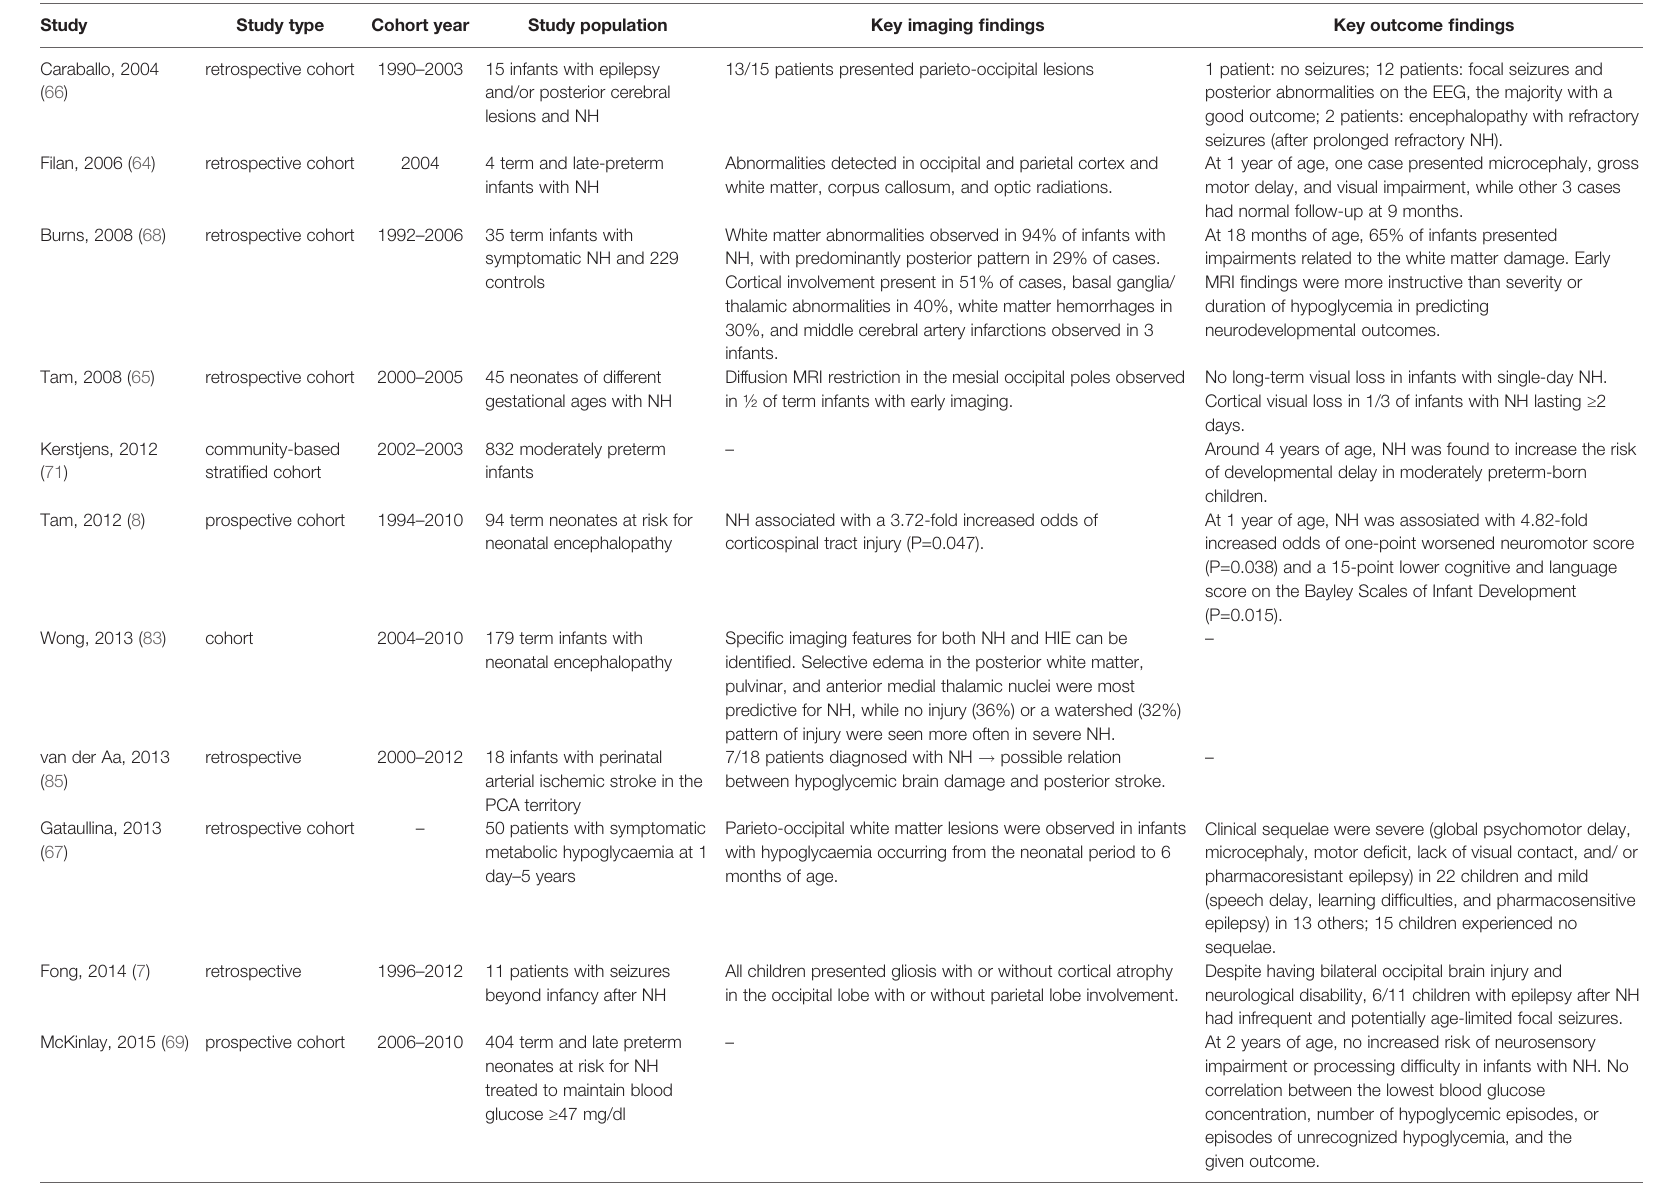
TABLE 2 | A summary of cited studies regarding neurodevelopmental outcomes and other brain injuries in infants with neonatal